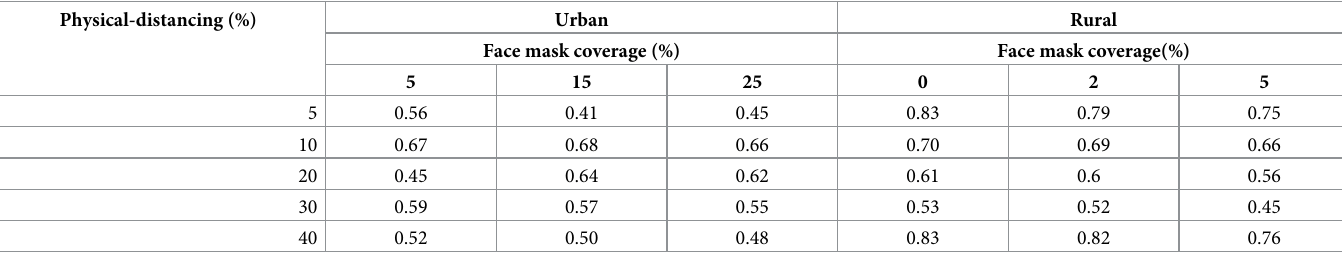
Table 5. Summary of R o under the implementation of different NPIs with different adherence levels in urban and rural populations of Ethiopia. The prevalence of hygiene measures (hand washing) is assumed to be 30% and 20% in urban and rural population of Ethiopia after the first seven months. Physical-distancing